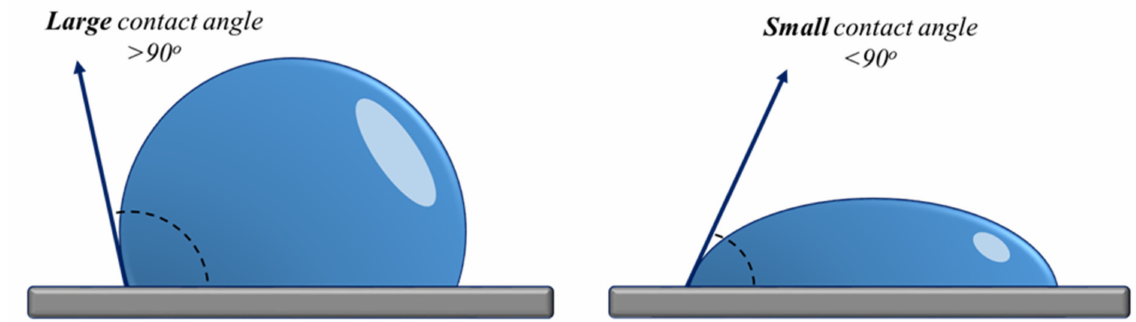
Figure 4. Contact angle measurement.